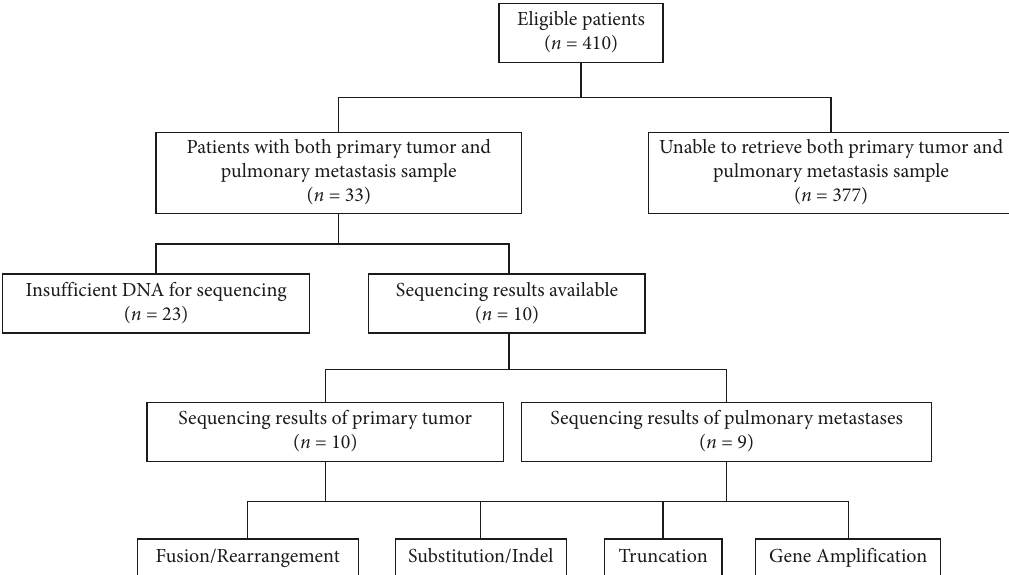
Figure 2: Availability of primary tumor and pulmonary metastasis samples.